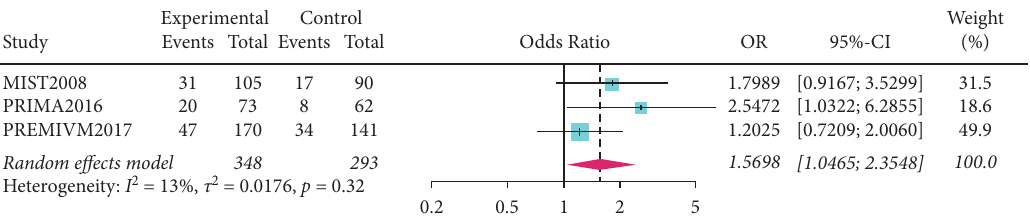
Figure 5: Forest plot for resolution of migraine headache for migraine with aura. Table 2: Sensitivity analysis of interconversion between the fixed-effects model and random-effects model and exchange of statistical values. Risk